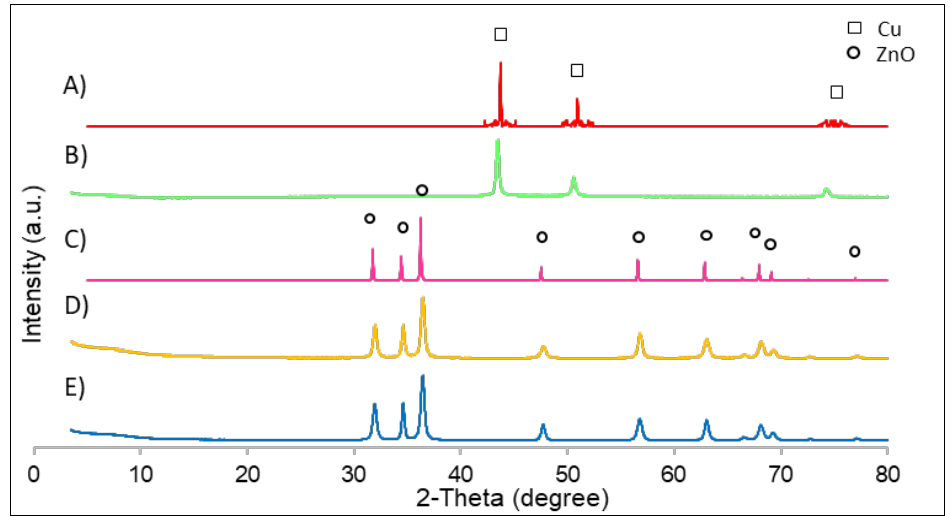
Figure 1. XRD patterns of all catalysts: ( A ) Cu nanoparticle simulation; ( B ) Cu nanoparticles; ( C ) ZnO nanoparticle simulation; ( D ) ZnO nanoparticles with PVP; ( E ) ZnO nanoparticles.